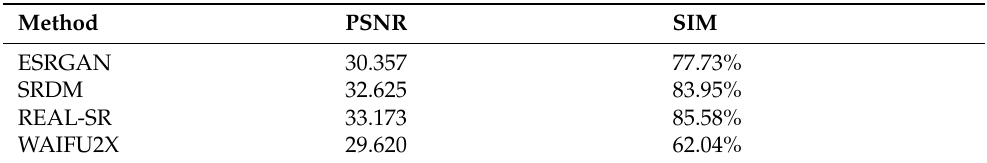
Table 1. Evaluation